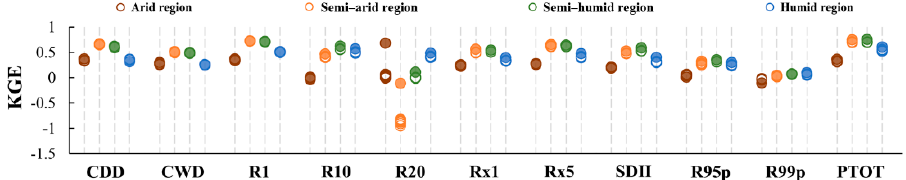
Figure 2. Scatter plots of model performance showing the Kling–Gupta efficiency (KGE) values for the 11 simulated precipitation indices in four regions. The results are from CMIP5 models and the multi-model ensemble mean (ensemble mean model is shown by solid circles, and single models are shown by hollow circles) in 1961–2005.